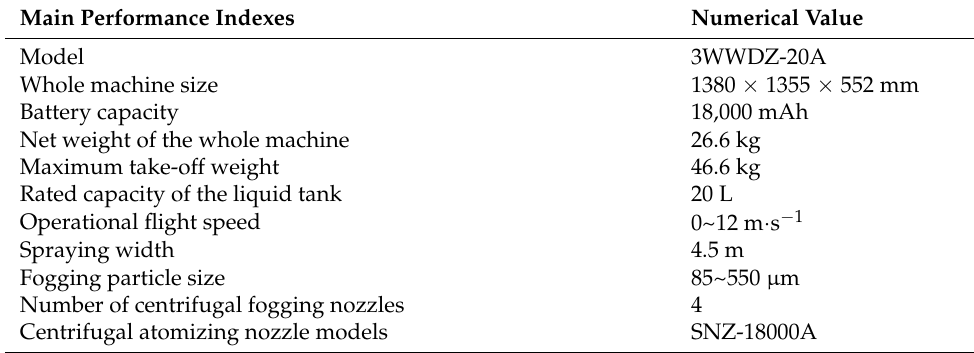
Table 1. Main performance indexes of XP 2020